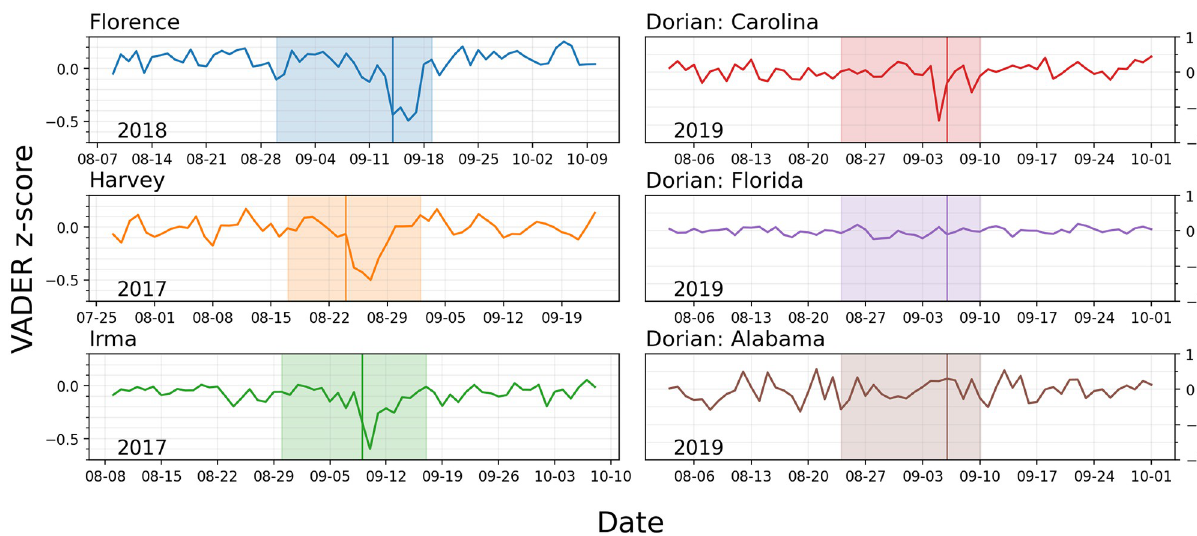
Fig 4. Z-score normalized sentiment of tweets in each region. For each affected region, the sentiment was the lowest during the hurricane. In the case of Hurricane Dorian, only the Carolina showed a large drop. Alabama and Florida, on the other hand, showed very little changes in sentiment throughout the whole time